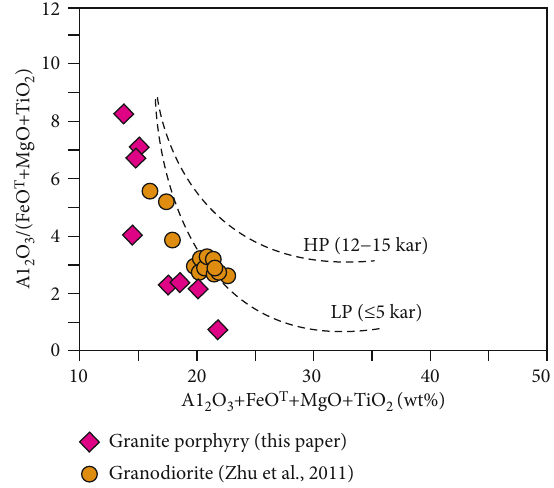
Figure 22: Composition diagrams of the granite porphyry and granodiorite. The area between the high-pressure (12-15kbar) and low-pressure ( ≤ 5 kbar) curves encompasses the range of depths at which mantle-crust interaction takes place (After Douce, 1999